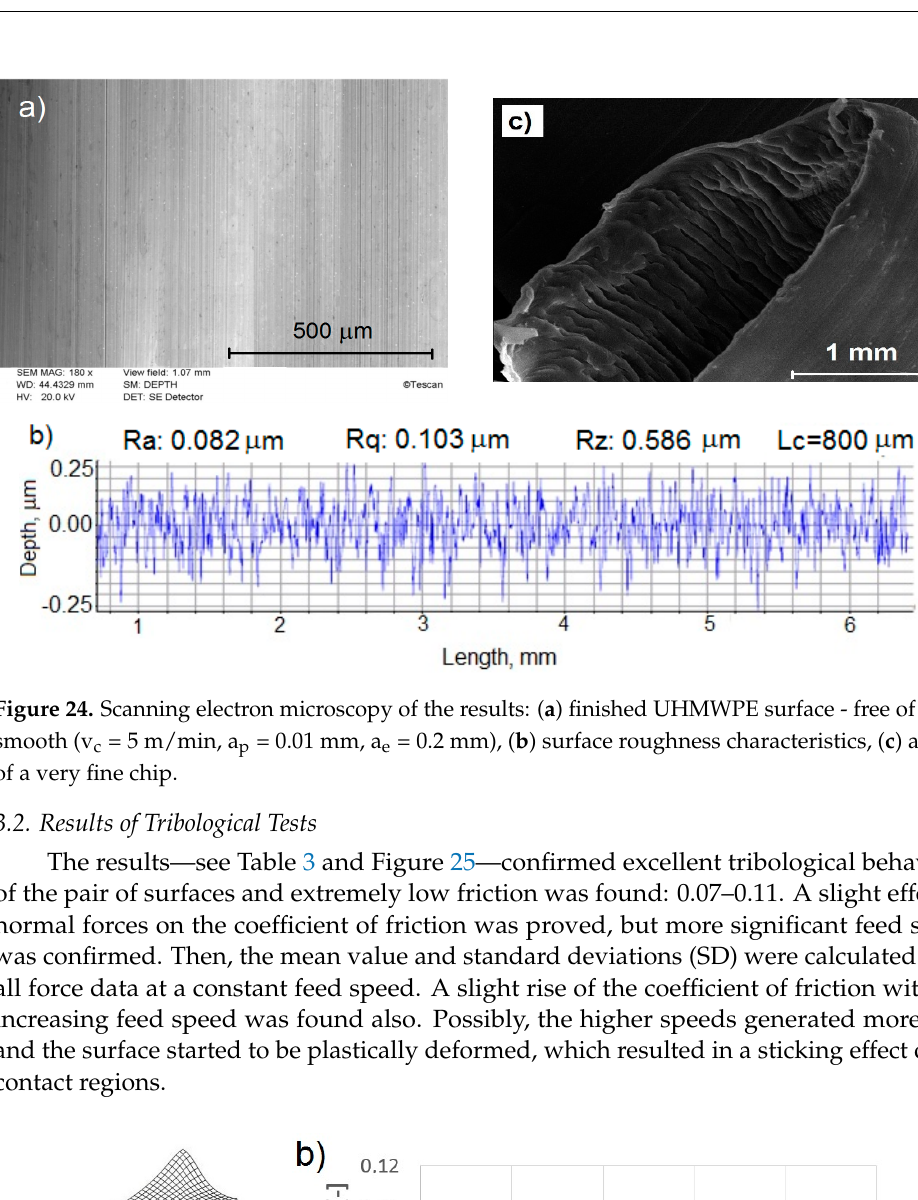
15 of 19 Figure 23. A comparison of the surfaces. ( a ) before ironing ( b ) after linear ironing with the preheated iron cylinder. Table 2. Average surface roughness after machining and thermal ironing. Ra [ μ m]